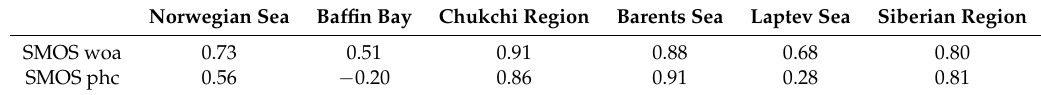
Table 2. Correlation of SMOS SSS with respect to TARA